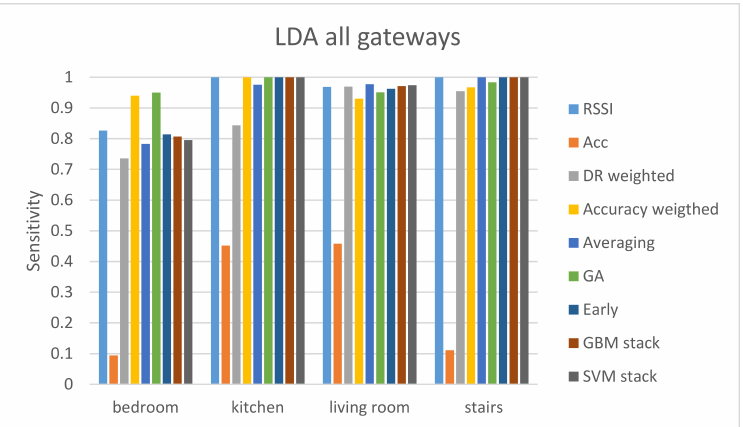
Figure 6. Sensitivity results of the LDA classifier for the evaluation protocol 2.